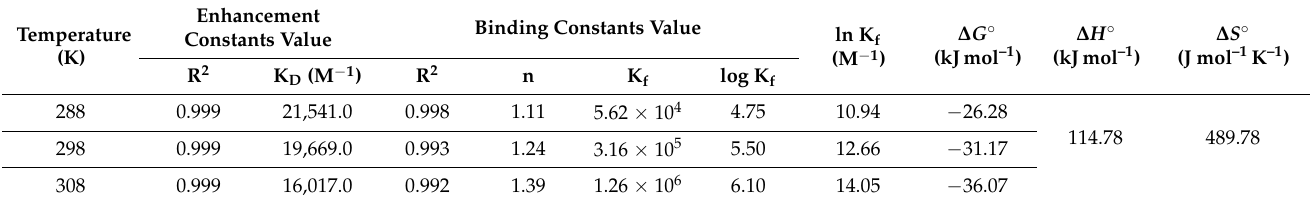
Table 1. Stern–Volmer constants, binding constants, binding sites, and thermodynamic parameters. Enhancement Temperature Constants (K)